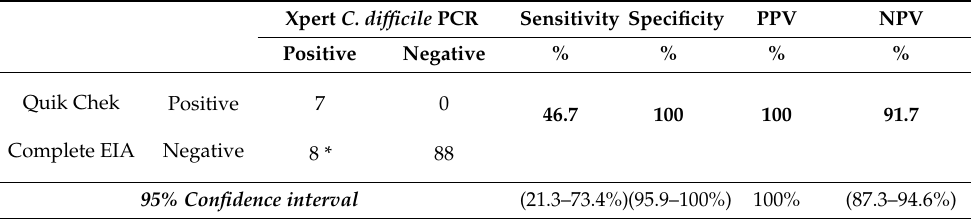
Table 1. Comparison of Quik Chek CompleteEIA results with Xpert C. difficile PCR (prior to implementation of the algorithm; n =